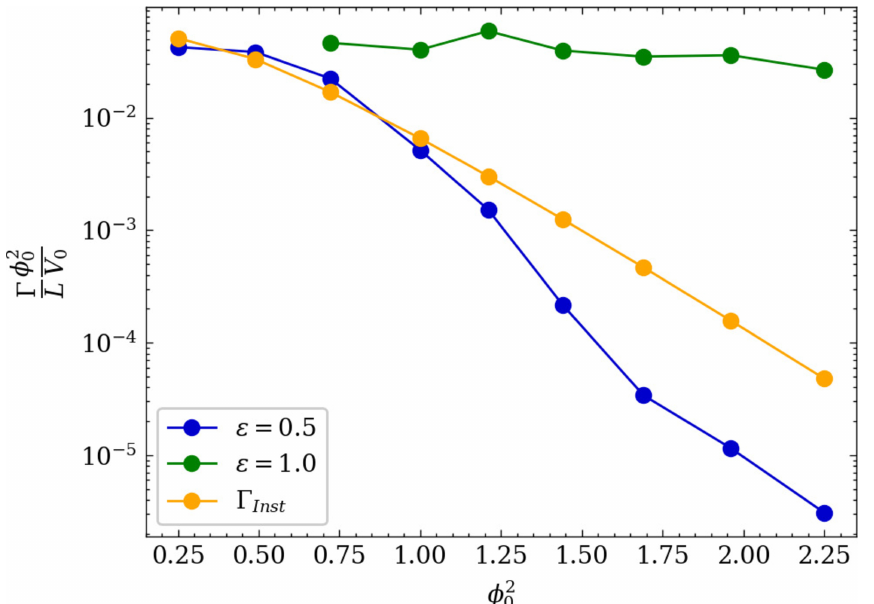
Figure 4 . The nucleation rate from the instanton model and the simulations with (cid:15) = 0 . 5 and (cid:15) = 1 . The lattice simulation has N x = 512 , am f = 0 . 06 and integration step size dt = 0 . 05